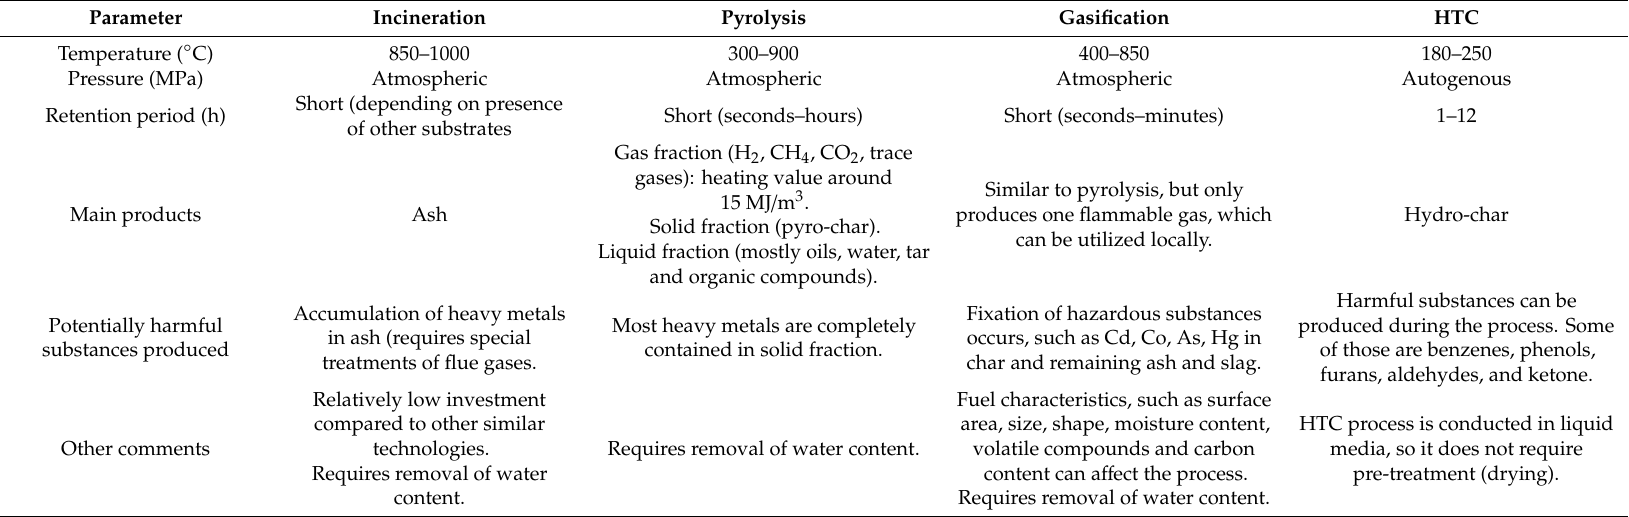
Table 3. Comparison of technologies of thermal methods for sewage sludge treatment